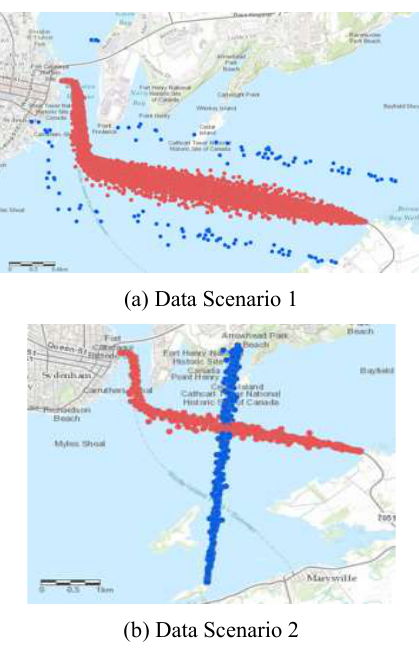
Figure 1. Tested datasets at Wolfe Island Ferry data collected January